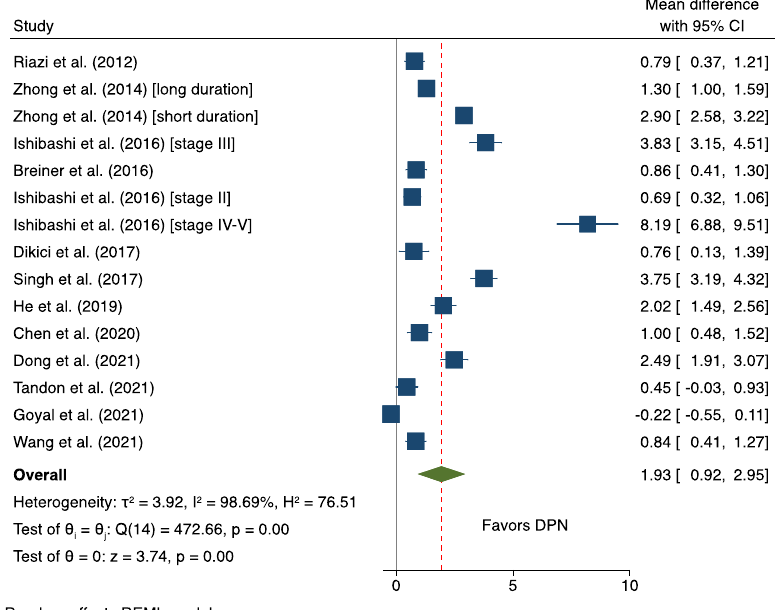
Figure 3. Mean differences comparing tibial nerve cross-sectional area between DPN and DM subgroups. The squares indicate the cross-sectional areas from 16 studies [8–11,13–16,24–31]. Size of each square is relative to the study’s weight. Whiskers indicate the upper and lower limits. The green diamond and dotted line indicate the overall cross-sectional area in each subgroup.